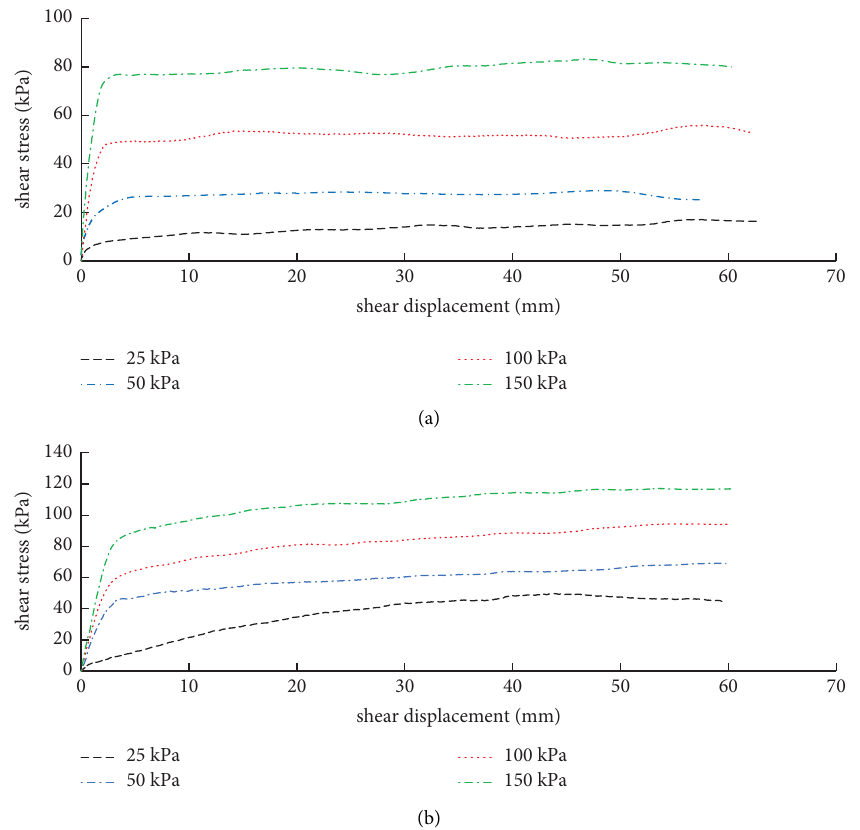
Figure 7: Curve of relationship between shear stress and shear displacement. (a) Case 1: gangue without geogrid. (b) Case 2: gangue with geogrid.